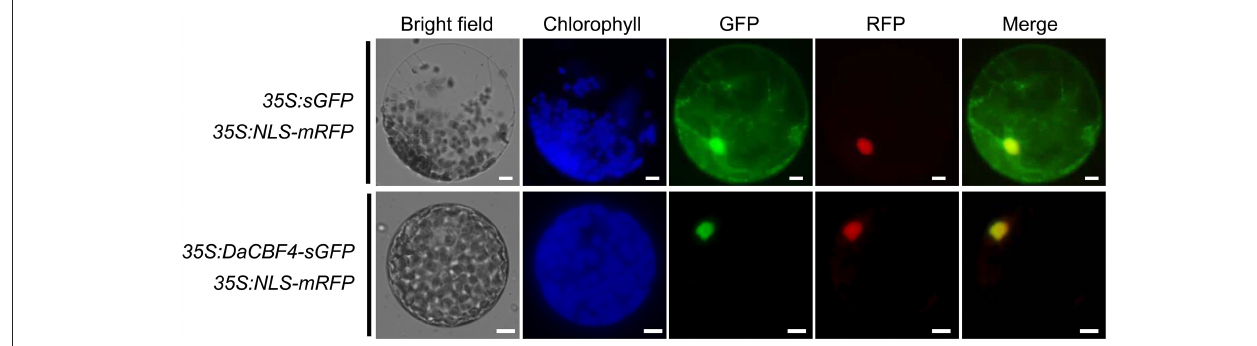
FIGURE 1 | Subcellular localization of DaCBF4. Tobacco ( Nicotiana benthamiana ) leaves were co-infiltrated using Agrobacterium that contained the 3 5S:DaCBF4-sGFP or 35S:sGFP construct. NLS-mRFP was used as a nuclear marker protein. Scale bars = 5 µ m.